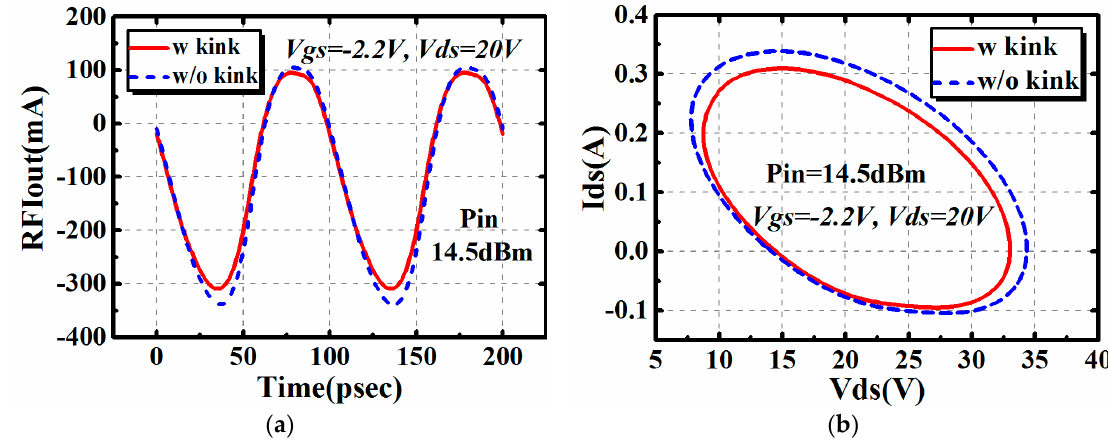
Figure 8. The influence brought by the I–V kink effect on time domain characteristics of AlGaN/GaN HEMTs @10GHz: ( a ) time domain waveform and ( b ) AC dynamic load line.